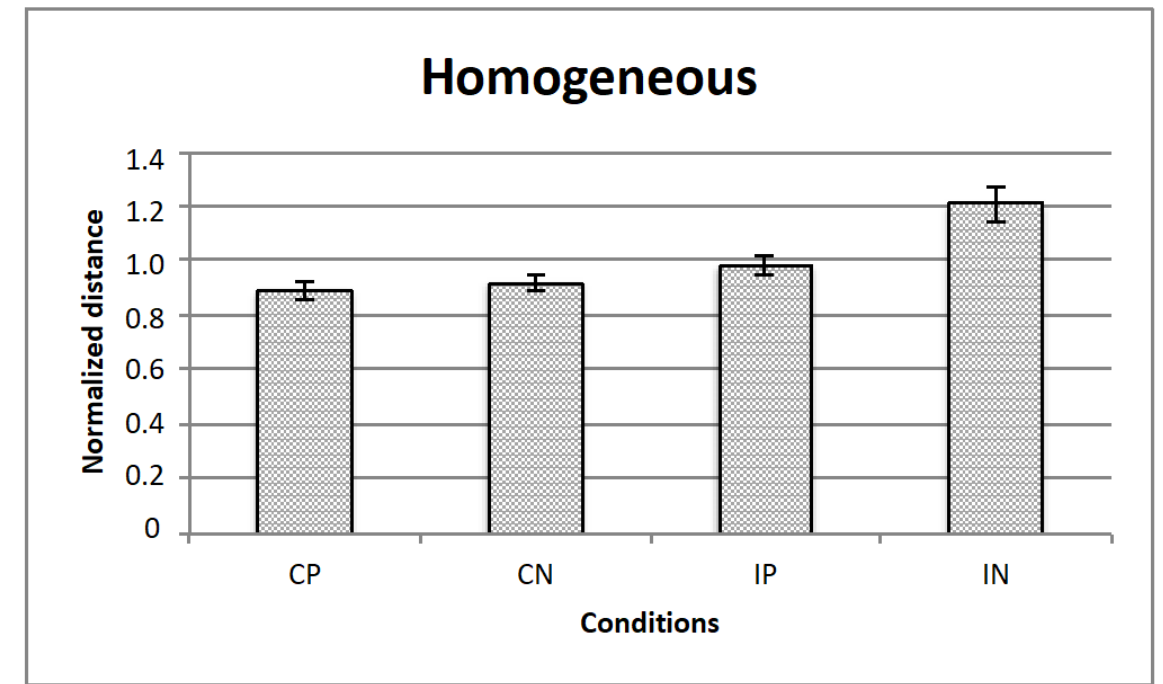
Figure 5. The figure represents the data for homogeneous illumination: The horizontal axis represents the experimental conditions (i.e., CP, CN, IP, IN), while the vertical axis is for the normalized critical distance (i.e., averaged across observers). Standard errors are reported.